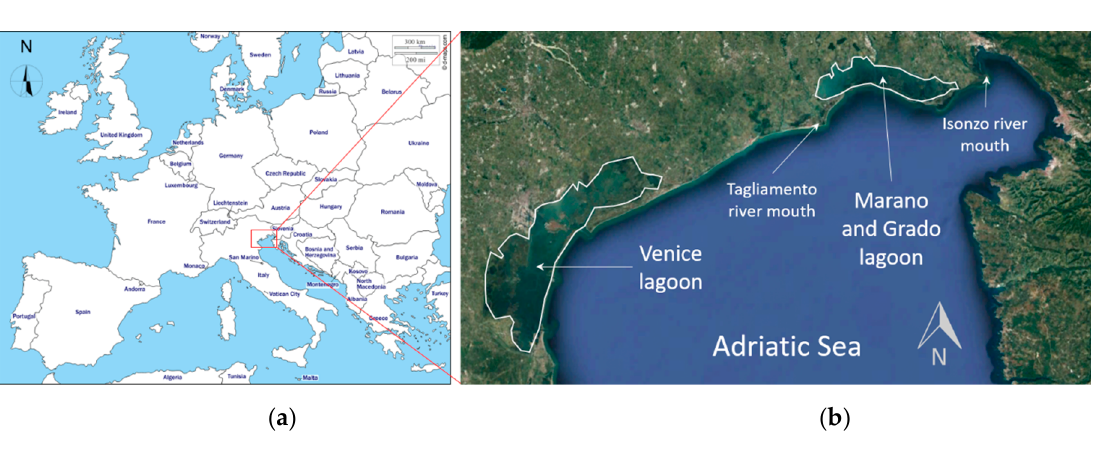
Figure 1. Venice lagoon and Marano and Grado lagoon depicted ( a ) in the European context and ( b ) in the northern Adriatic Sea.